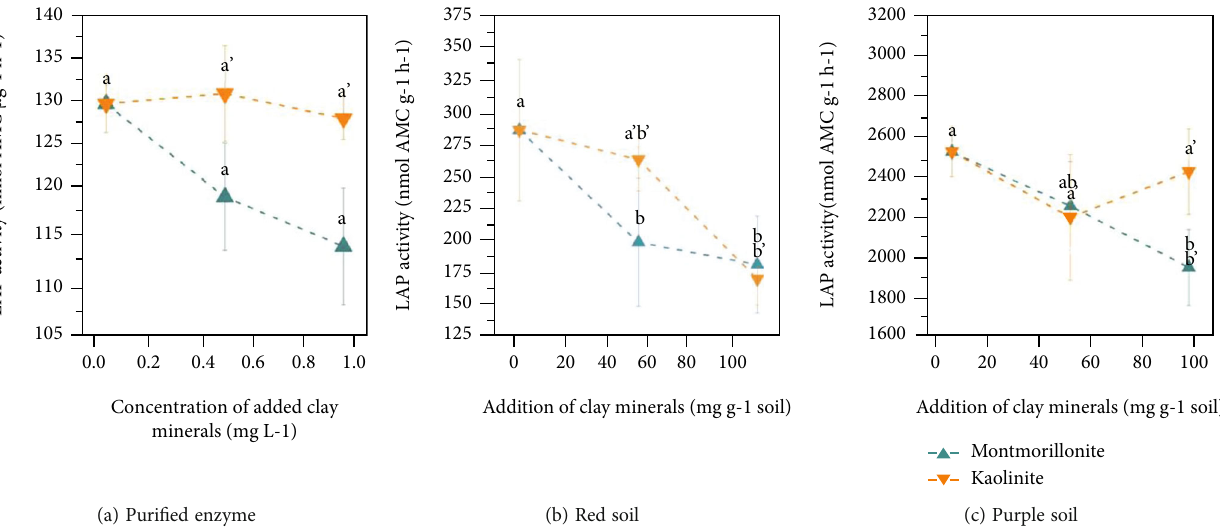
Figure 4: E ff ect of adding di ff erent amounts of montmorillonite and kaolinite on LAP activity in puri fi ed LAP, LAP in red soil, and LAP in purple